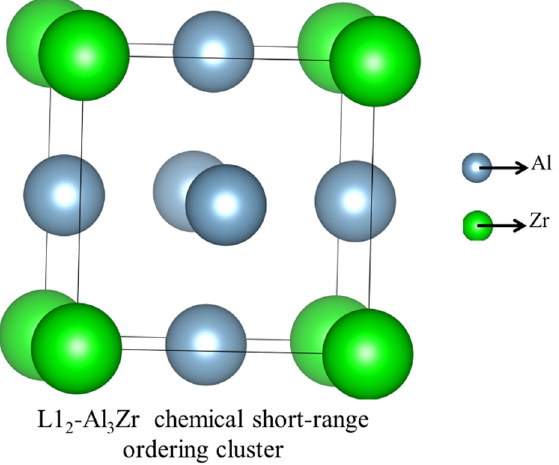
Table 1. The size mismatch and the electronegativity differences between the solute atoms Zr and host Al atoms, data from [36–38].